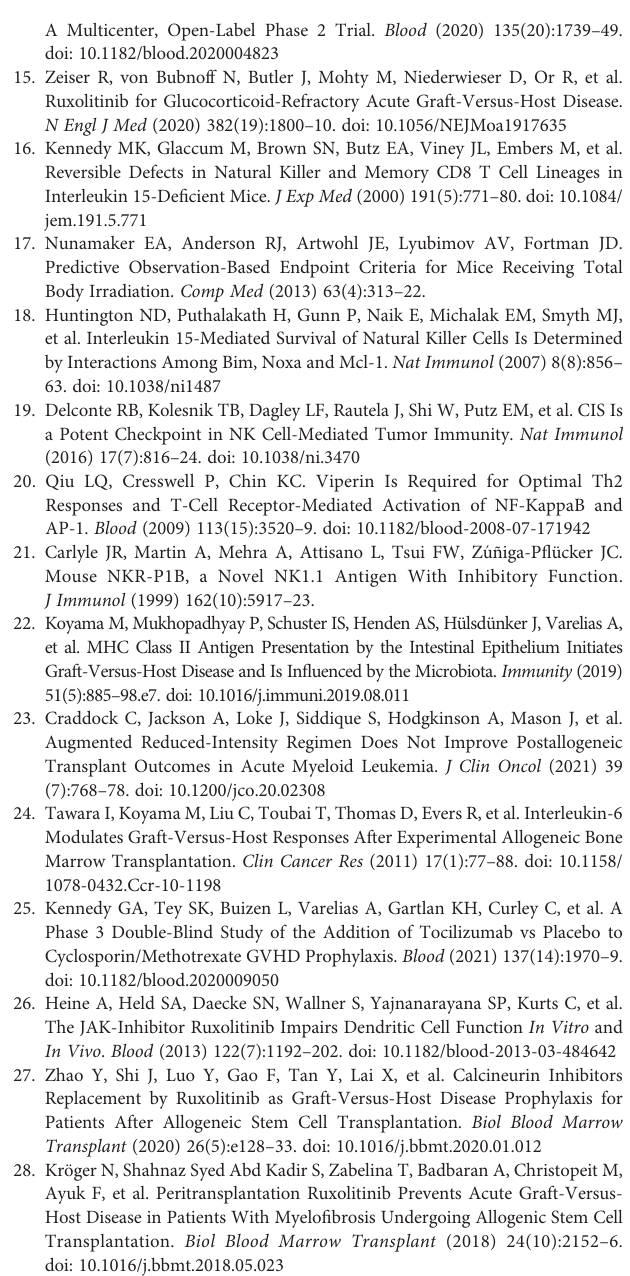
Supplementary Figure 1 | IL-15 knockout mice have reduced NK and CD8+ T cells in the bone marrow. Untreated IL-15KO mice and WT C57BL/6 mice aged